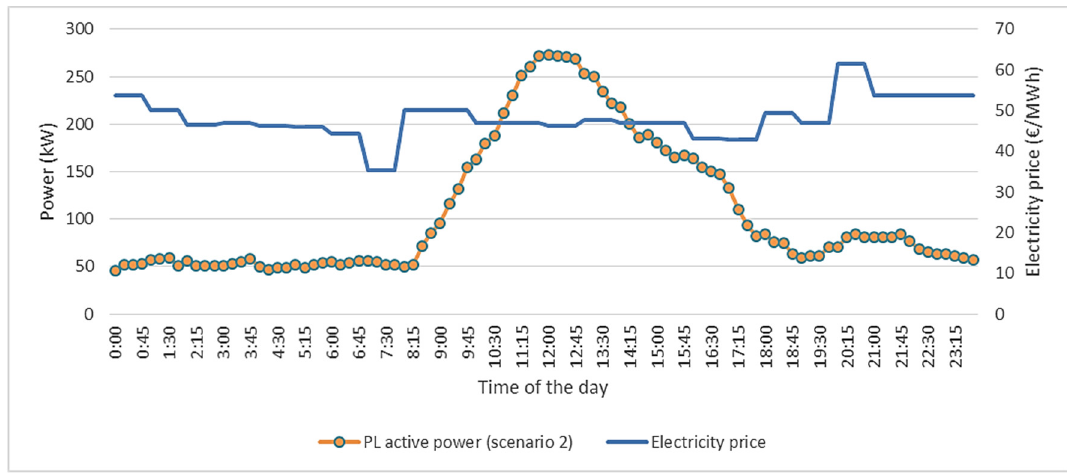
Figure 9. PL’s active power in scenario 2 and electricity price.